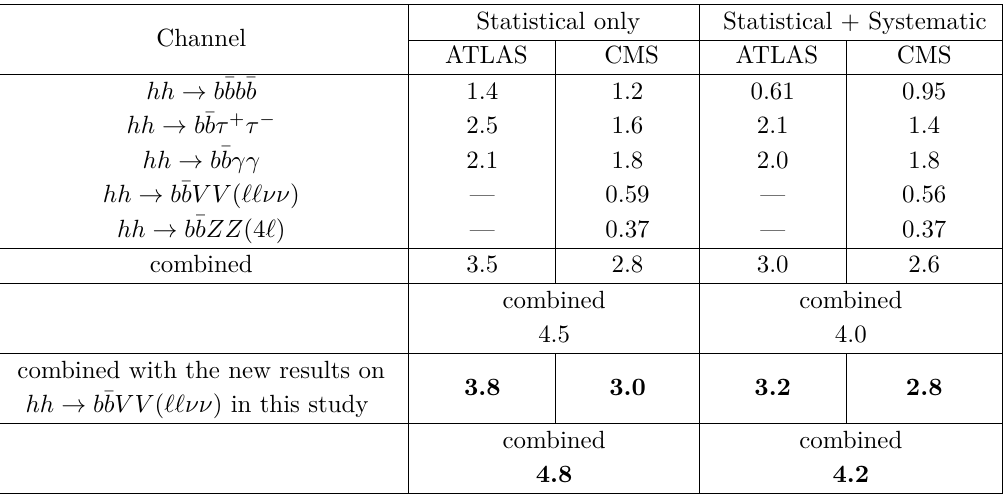
Statistical only Statistical + Systematic Channel ATLAS CMS ATLAS